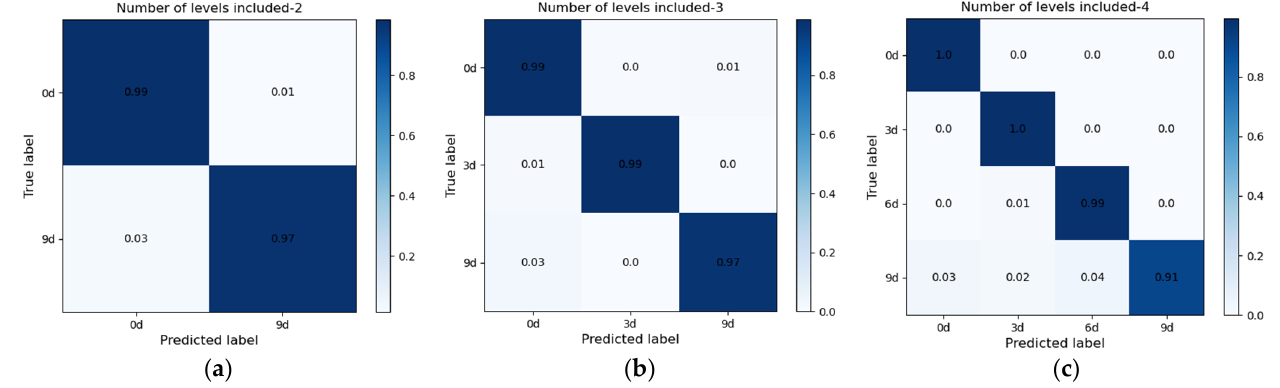
Figure 6. Confusion matrix based on the DCNN model. ( a ) Confusion matrix of prediction sets for two vitality levels; ( b ) confusion matrix of prediction sets for three vitality levels; ( c ) confusion matrix of prediction sets for four vitality levels.